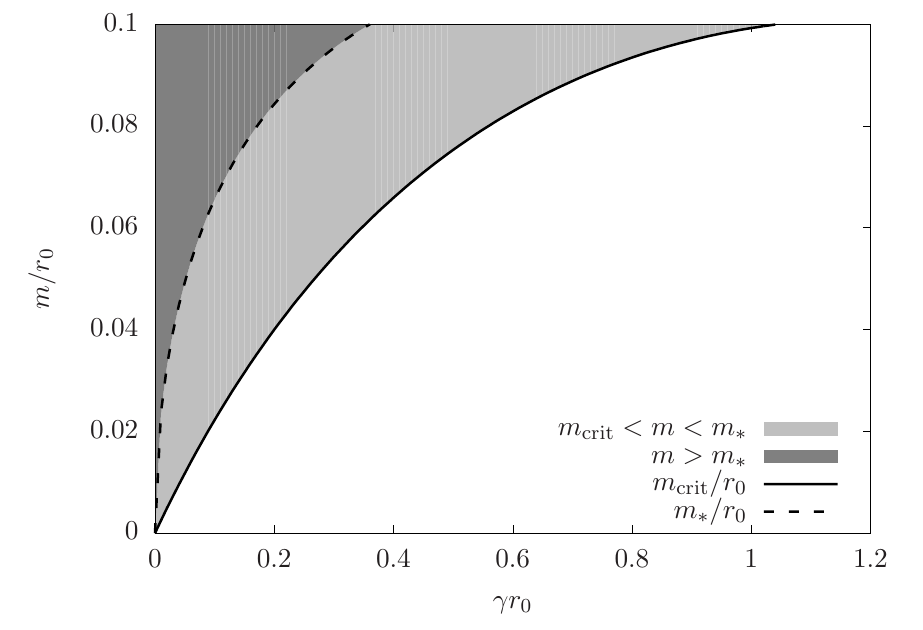
which ∗ which gives enhanced ∗